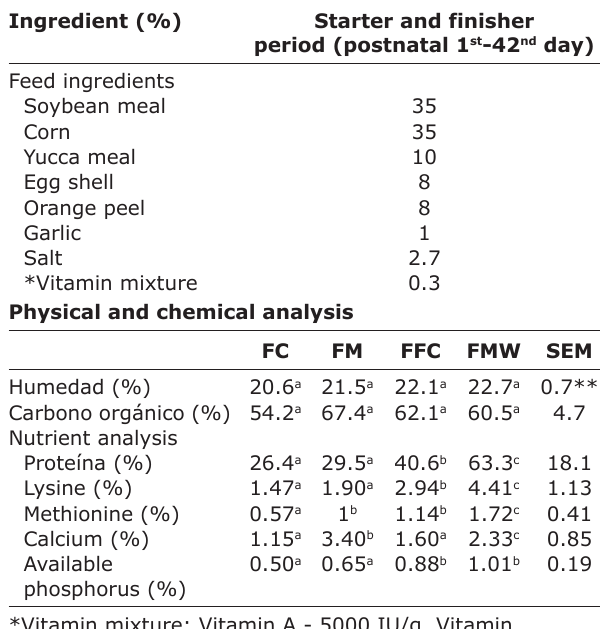
Table-1: Feed control ingredients and nutrient analysis of used diets during the starter and finisher periods by 42 nd